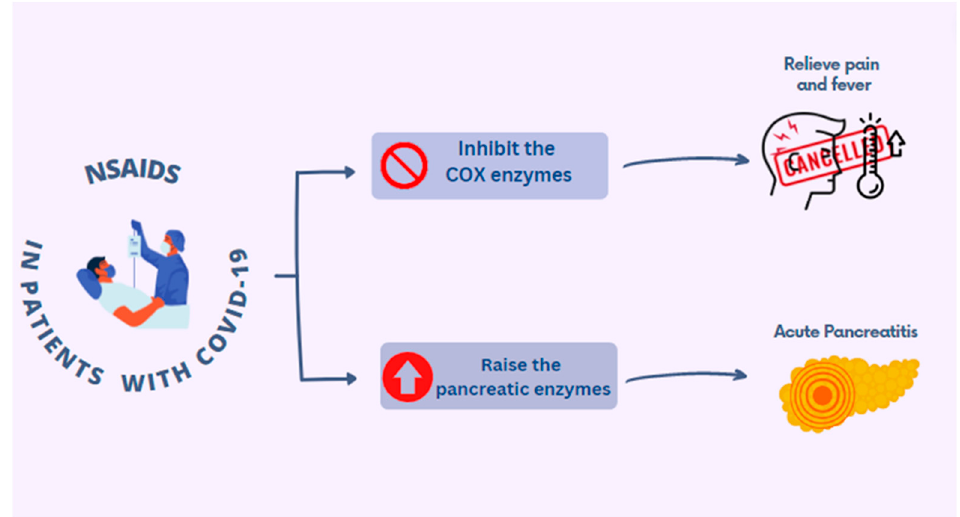
Figure 5. Non-steroidal anti-in fl ammatory drugs (NSAIDs) used for COVID-19 patients.